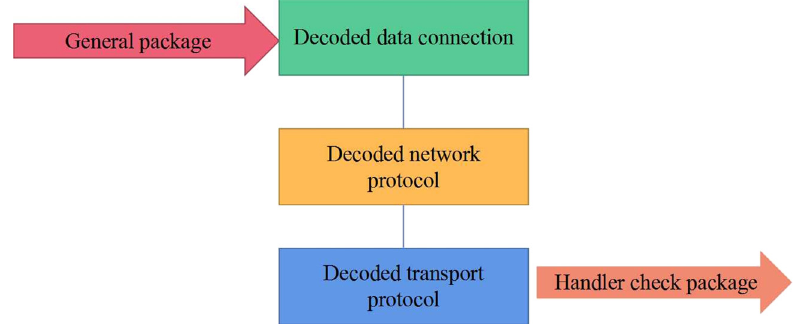
Figure 3: Speci fi c decoder work fl